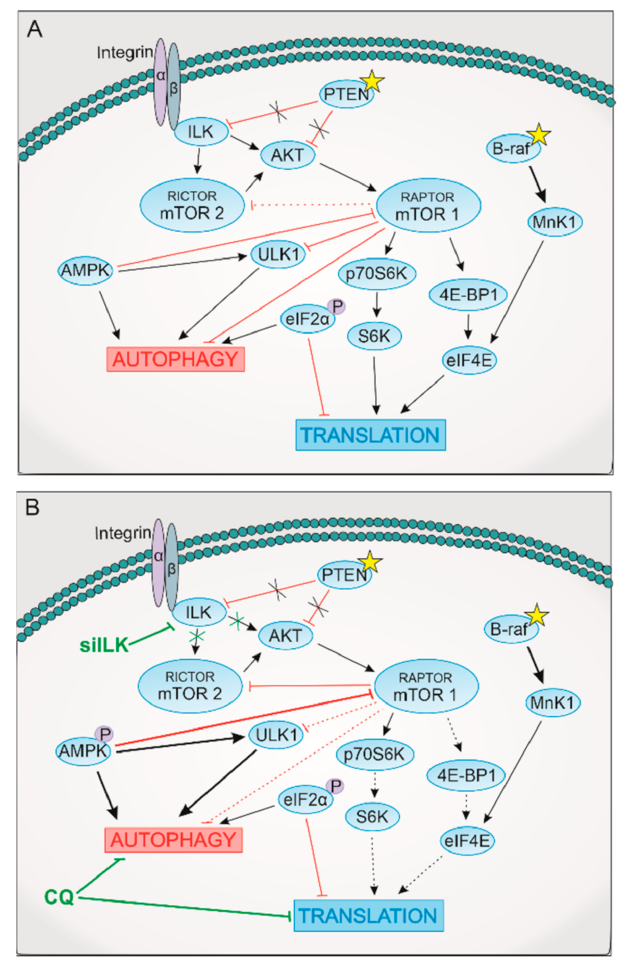
Figure 7. Model of the signaling pathway in tested melanoma cells. Red color—inhibition signals, black color—stimulation signals. ( A ) Mechanism of the ILK regulation of translation and autophagy in melanoma cells. ( B ) The influence of siILK and CQ treatment melanoma